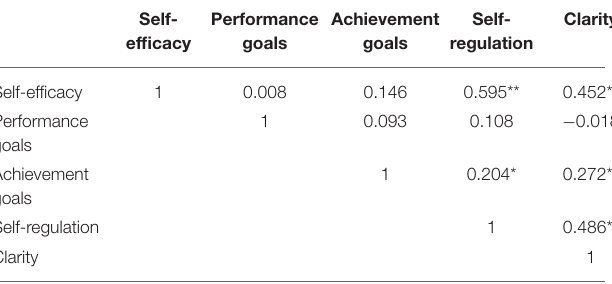
TABLE 6 | Correlations between variables at the start of the study ( n = 145).